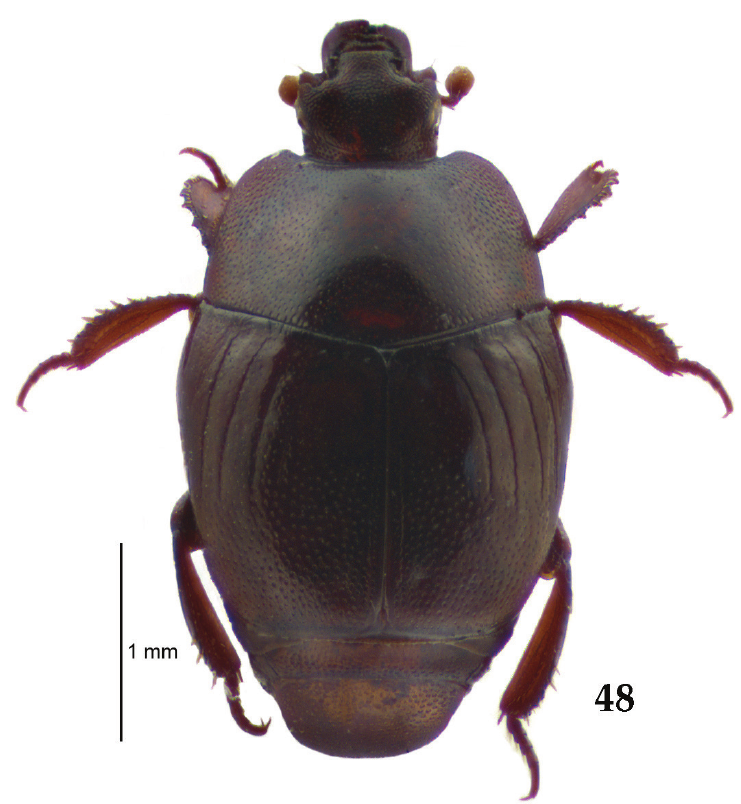
Figure 48. Euspilotus ( Neosaprinus ) rubriculus (Marseul, 1855) habitus, dorsal view/ left mesotarsus, right metatarsus and left hind leg missing, pinned, with the follow- ing labels: tiny, rectangular pink label, followed by: “107 / Saprinus / rubriculus / m. / N.” (round, green label, written); followed by: “Horn / 11 mars 43 ?” (almost illegible label, written); followed by: “6a rubriculus / N. Am” (written); followed by: “MUSEUM PARIS / COLL. / DE MARSEUL 1890” (printed); followed by: “TYPE” (red-printed label); followed by: “Saprinus rubriculus / Marseul, 1855 / LECTOTYPE / des. T. Lackner, 2014” (red label, written) (MNHN). The type locality of this species is “America?” with a question mark. It is unclear why Mazur (1997, 2011) does not mention this doubt with the type locality. This species was designated from unknown number of specimens and the lectotype designation fixes the identity of the species. Saprinus gnathoncoides Bickhardt, 1909: holotype, ♂ , side-mounted on a triangular mounting card, with the following labels: “Montevideo / 28.xi.[19]08 / J. Tremoleras” (black-margined printed-written); followed by: “ gnathoncoides / Bickh.” (written); fol- lowed by: “ gnathoncoides / m / det. Bickhardt” (written-printed); followed by: “Type” (red label, printed); “Zool. Mus. / Berlin” (printed); followed by: “10-152” (yellow label, pencil-written, added by the senior author); followed by: “10-166” (yellow